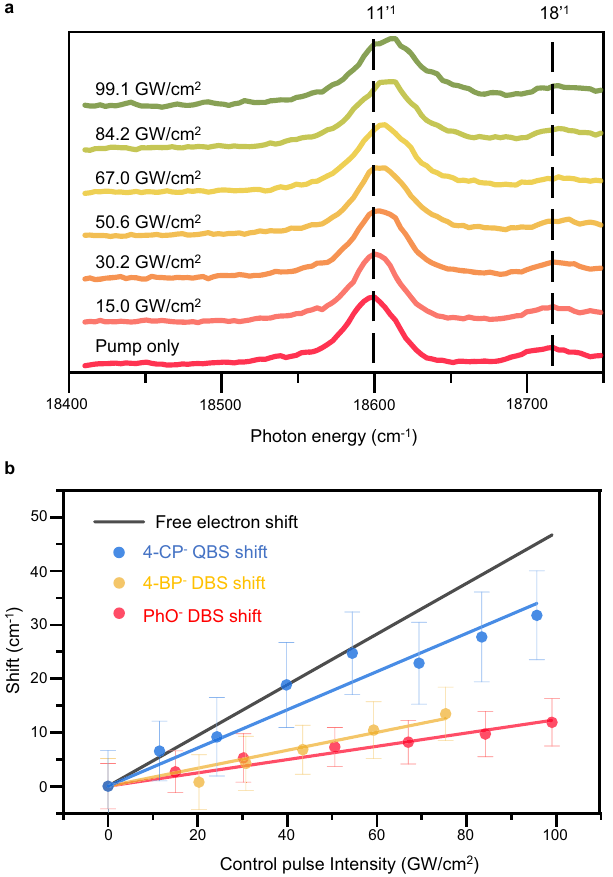
Fig. 3 The (control laser) power-depenent ponderomotive shifts. a Photodetachment spectra of the PhO − DBS at various intensities of the control laser pulse. Intensity of the control ps laser pulse for each spectrum is denoted. The most prominent 11 ′ 1 peak and adjacent 18 ′ 1 peak were labeled above the corresponding peaks (black dashed lines). b The blue- shift ( Δ ~ ν ) of the PhO − DBS (11 ′ 1 , red circle), 4-CP − QBS (12 ′ 1 , blue circle), and 4-BP − DBS (11 ′ 1 , yellow circle) are plotted versus the intensity of the ps control laser pulse. The ponderomotive shift of the free-electron model from Eq. (3) (black solid line) is shown for the comparison. The linear fi ts to the experiment are given with experimental error bars (±1 σ ), determined from the multiple measurements (>10) of the photodetachment spectra. The pump laser intensity was ~10 GW/cm 2 for the 4-CP − QBS whereas it was ~90 GW/cm 2 for the 4-BP − and PhO − DBSs. The same experiment with the much-reduced pump laser intensity (~10 GW/cm 2 ) has been carried out for the PhO − DBS, showing that the slope is barely in fl uenced by the pump laser intensity (Supplementary Fig. 5). Source data are provided as a Source Data fi